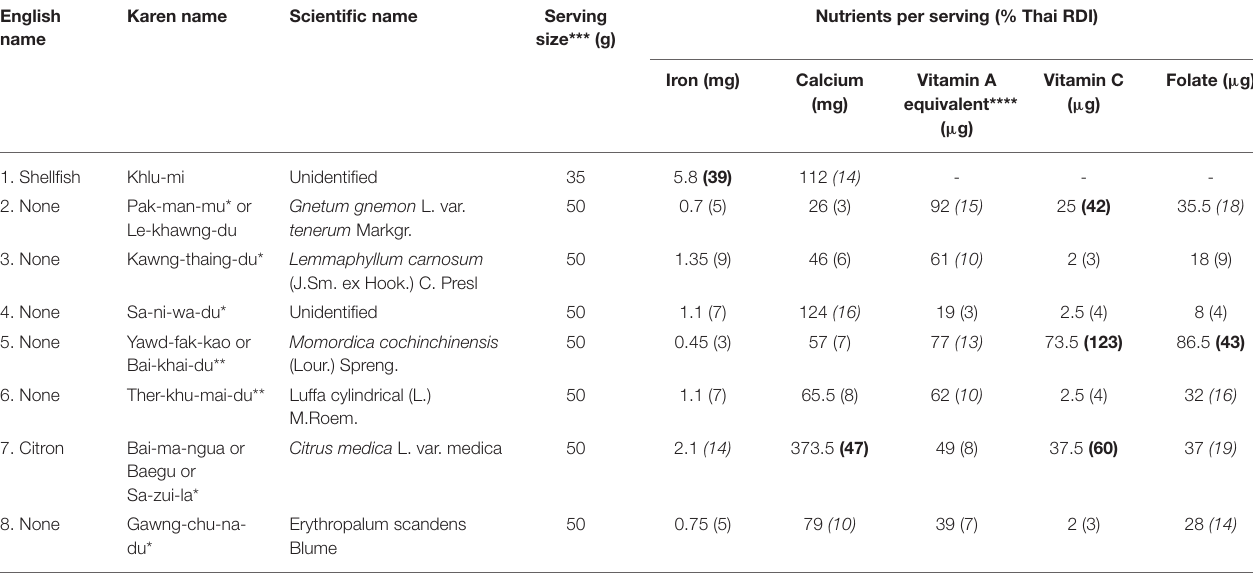
TABLE 5 | Nutrient data for Karen foods and potential dietary contributions for children 6 years and older.